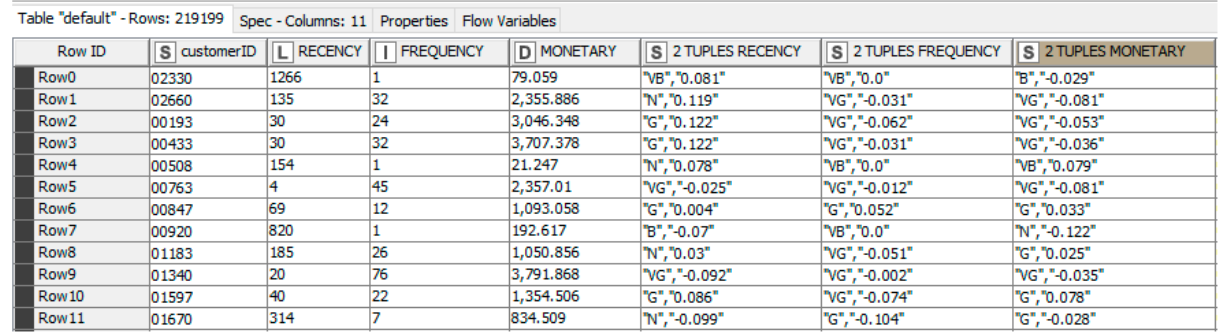
Figure 15. Output table from Knime. Sample of customers with their RFM variables and fuzzy linguistic 2-tuple recency, frequency and monetary attributes.